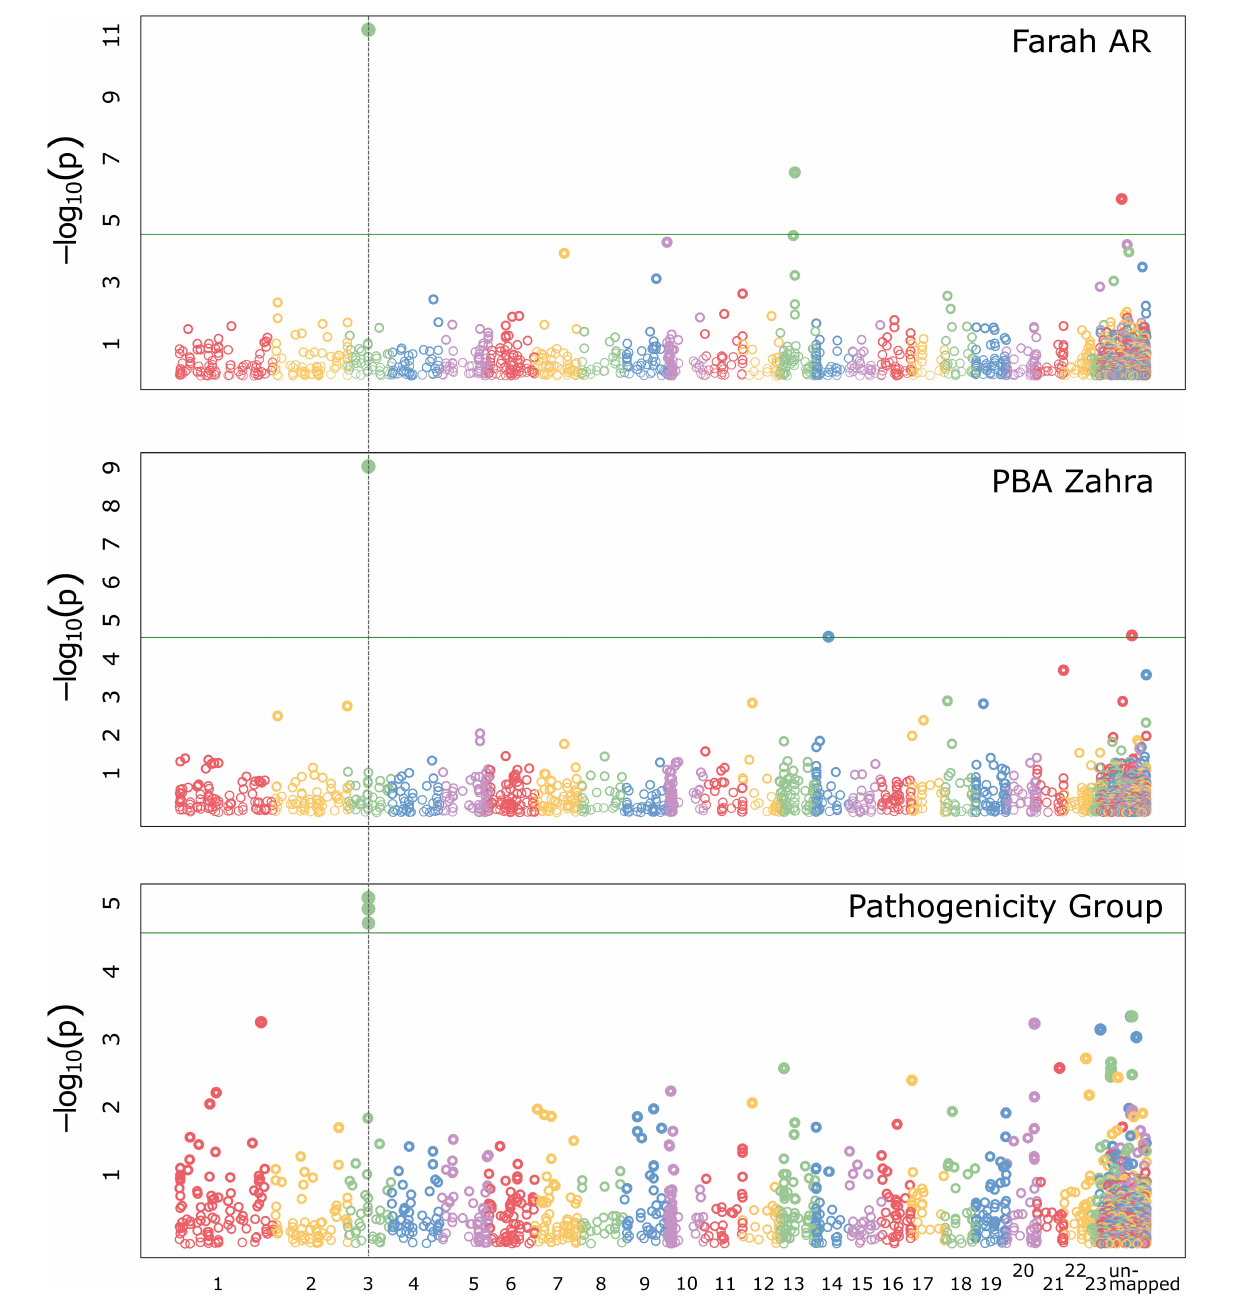
FIGURE 6 | Manhattan plots for GWAS analyses implementing the FarmCPU model in GAPIT with the significant trait-associated locus (dotted vertical line) that was identified by the association of two markers mapped in A. fabae isolate 206/15, on RagTag scaffold 3. The locus was associated with Farah AR and PBA Zahra disease traits and for the pathogenicity group